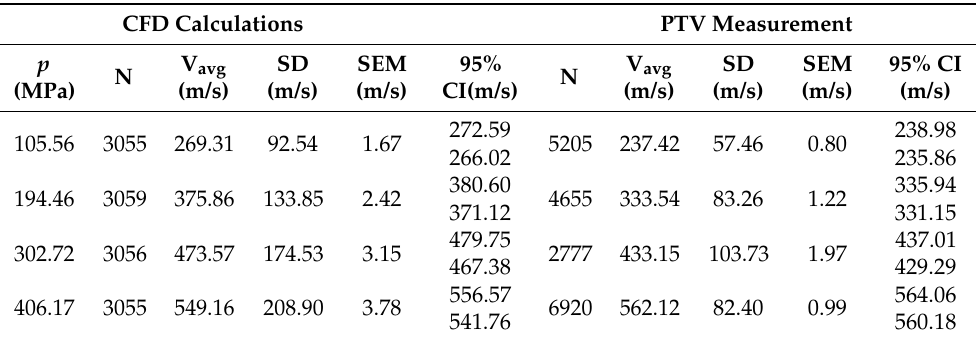
Table 5. Comparison of the average values of abrasive particle velocities from CFD calculations and PTV measurement—abrasive mass flow rate of 400 g/min.